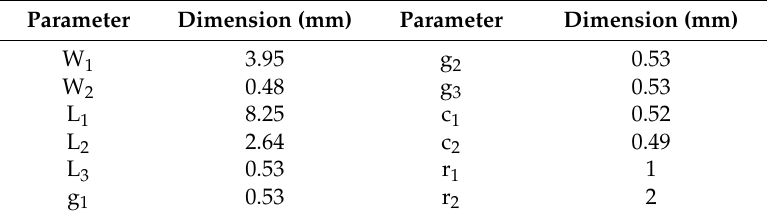
Figure 2. The magnitude of S-parameters ( S 11 and S 21 ) for the reported unit cell (Figure 1).